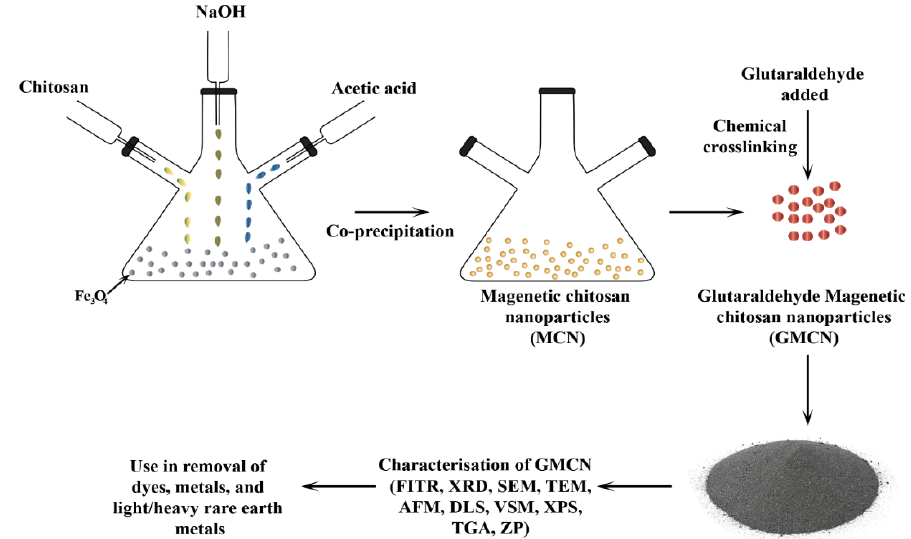
Figure 6. Reaction method of magnetic chitosan NPs cross-linked by glutaraldehyde.